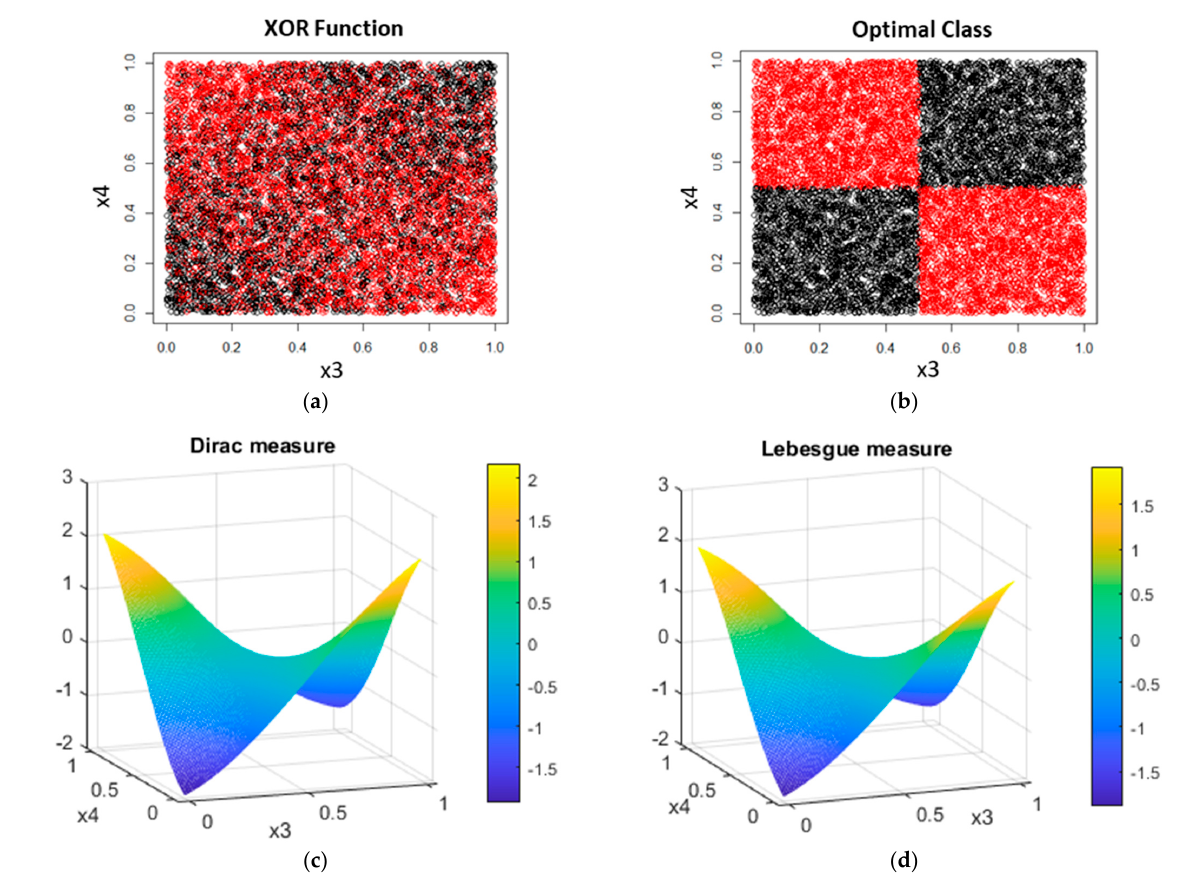
Figure 3. Class allocation for the 2-circle synthetic data set as a function of x 1 and x 2 showing: ( a ) The stochastic class labels; and ( b ) The correct classes that are used to fi nd the optimal AUC.